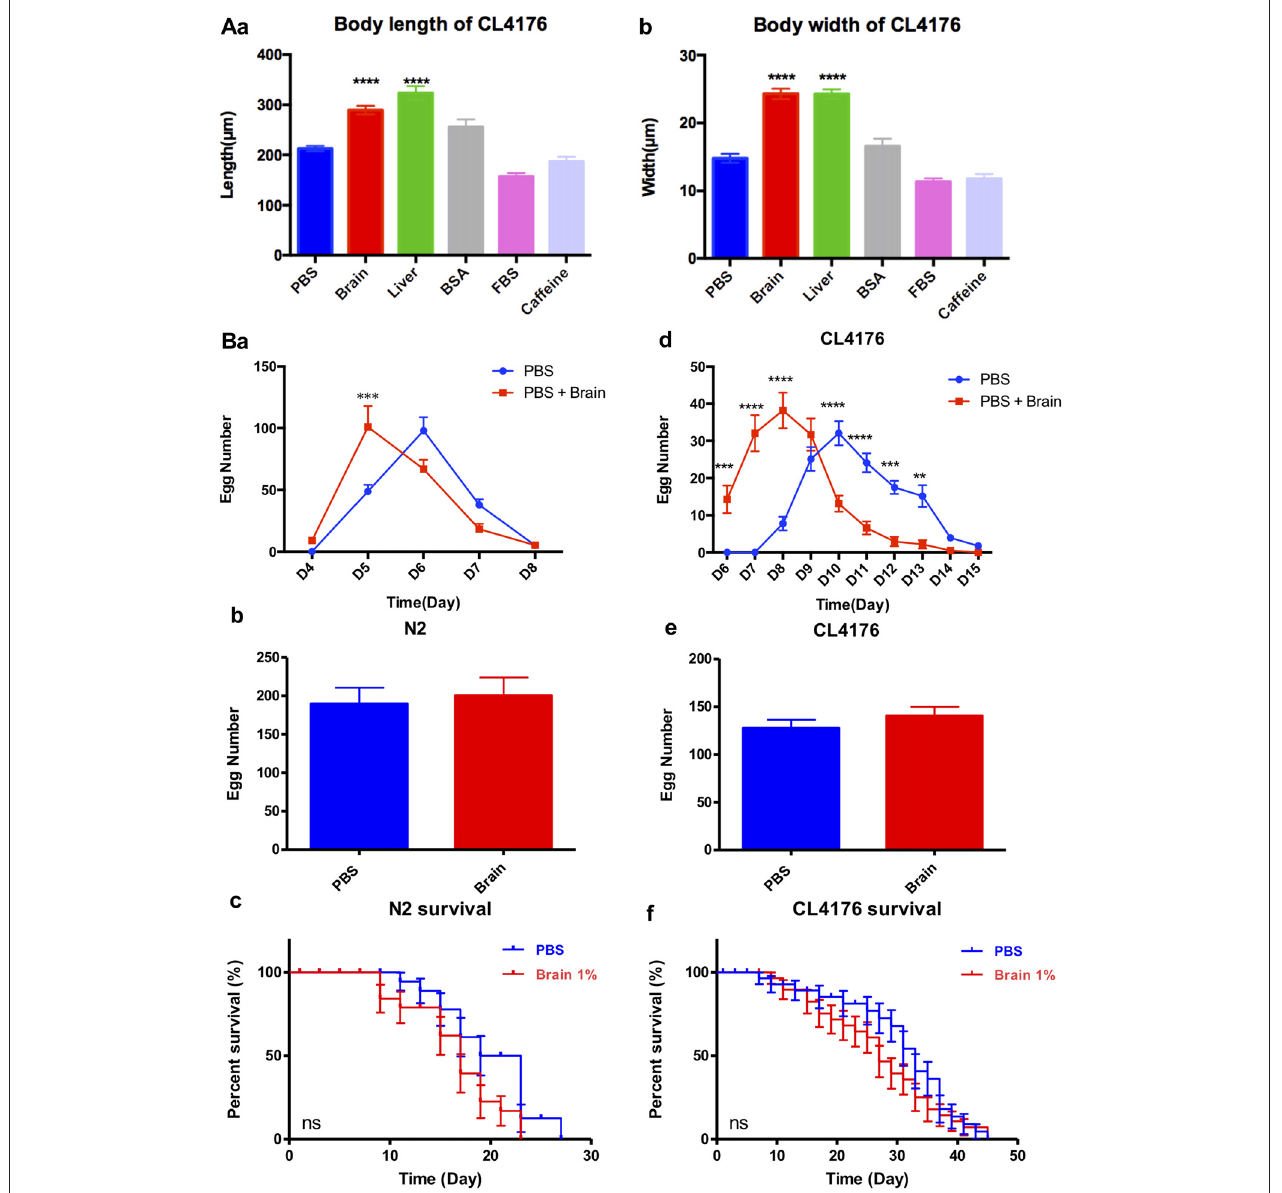
FIGURE 5 | The effect of brain extracts on the growth of CL4176 and WT N2 worms. (A) The effect of brain extracts on body sizes in CL4176 worms. (a) The body length of worms. (b) The body width of worms. Data were analyzed with one-way ANOVA, Tukey’s multiple comparisons post hoc that each group was compared with the PBS group. (B) The effect of brain extracts on fertility and lifespan of worms. (a–c) The egg number in each spawning day, total egg number and life span of N2 worms. (d–f) The egg number in each spawning day, total egg number, and life span of AD transgenic CL4176 worms. Egg numbers by days were analyzed with two-way ANOVA, Tukey’s multiple comparisons post hoc . Total egg numbers were analyzed with unpaired Student’s t -test. Life spans were presented as survival curves and analyzed with a paired log rank test. ∗∗ P < 0.01; ∗∗∗ P < 0.001, ∗∗∗∗ P <